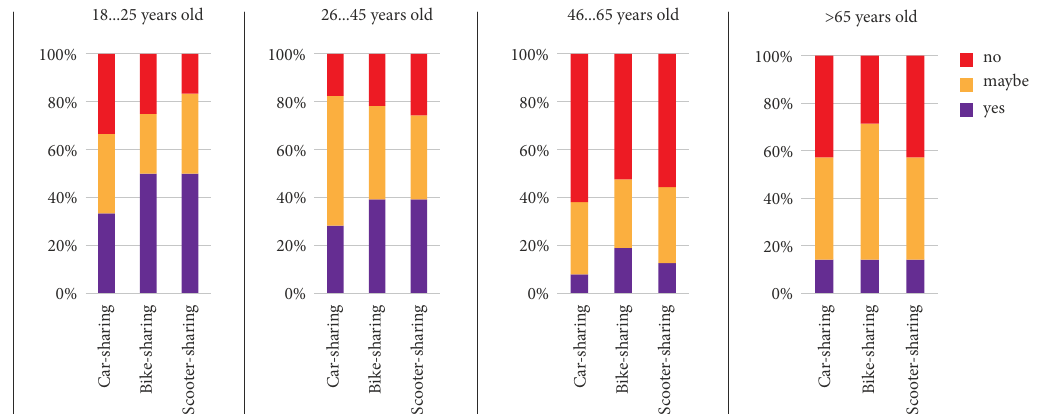
Figure 5. Distribution of residents answers whether they would use the sharing mobility system if it appeared next month by the type of transport mode and by age group